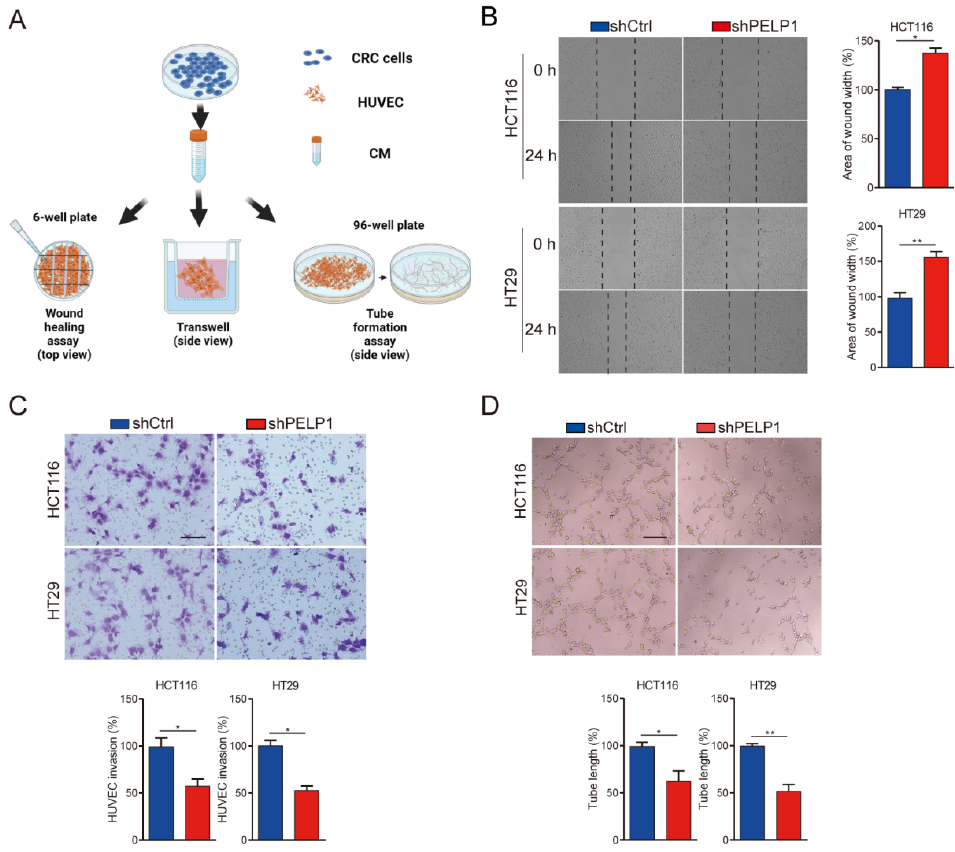
Figure 2. Down-regulation of PELP1 attenuates angiogenesis in vitro: ( A ) Schematic diagram of the HUVECs experiments in this study. ( B ) Representative images of wound healing in HUVECs treated with CM from shCtrl CRC cells or shPELP1 CRC cells (left panel). Scale bar: 200 µm. Histograms with the fold change in wound closure formed by the indicated cells (right panel). ( C ) Representative images of cells invasion in HUVECs treated with CM from shCtrl CRC cells or shPELP1 CRC cells (upper panel). Scale bar: 200 µm. Histograms with the fold change in the number of invasion cells formed by the indicated cells (lower panel). ( D ) Representative images of tube formation in HUVECs treated with CM from shCtrl CRC cells or shPELP1 CRC cells (upper panel). Scale bar: 200 µm. Histograms with the fold change in the length of tube-like formation formed by the indicated cells (lower panel). Data are shown as the means of three independent experiments or representative data. Error bars indicate SD.* p < 0.05, ** p < 0.01, by Student’s t -test.